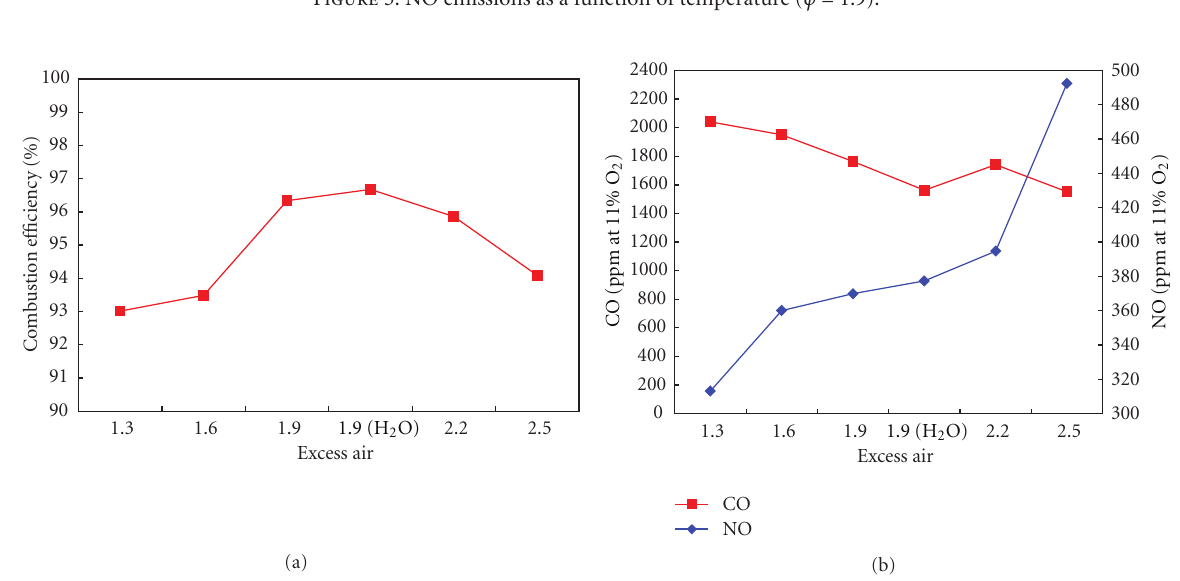
Figure 5: NO emissions as a function of temperature ( ϕ = 1.9).